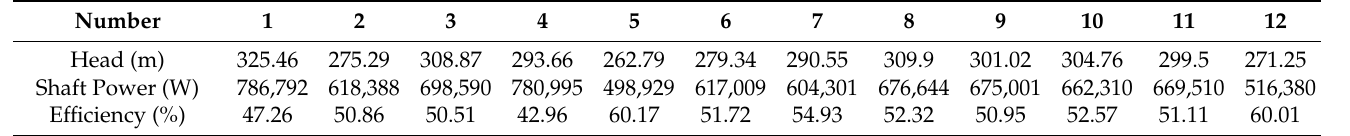
Table 6. CFD simulated results of the Plackett–Burman